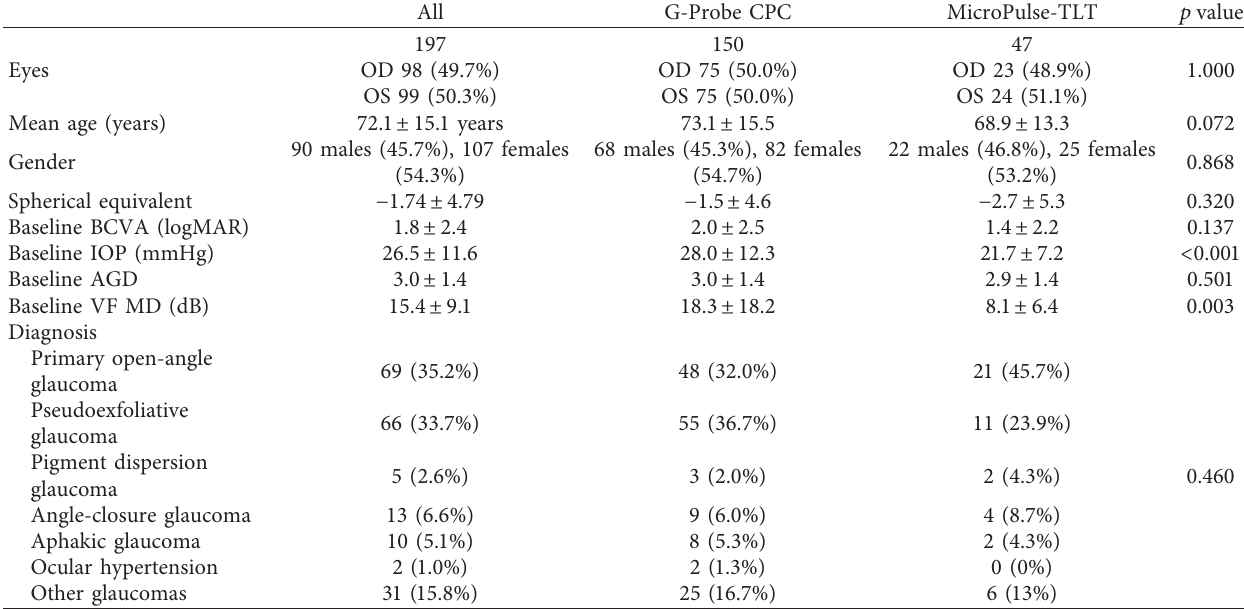
Table 1: Demographical